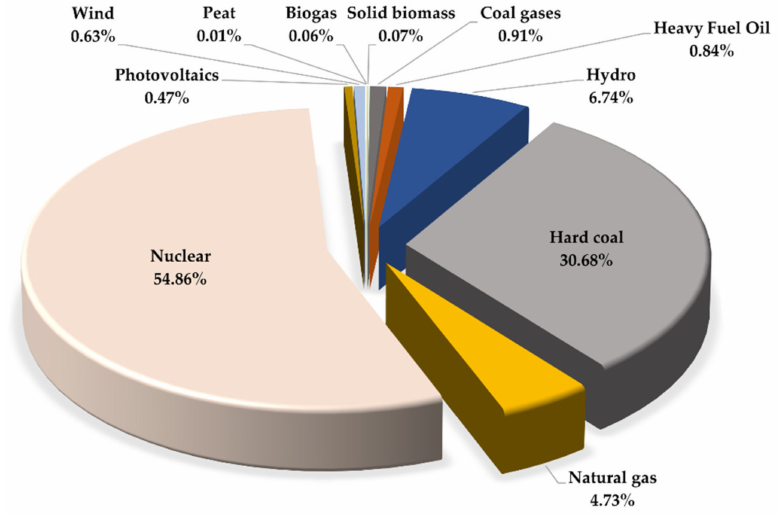
Figure 5. Electricity mix for Ukraine (2021). (Source: GaBi 8.0 database).